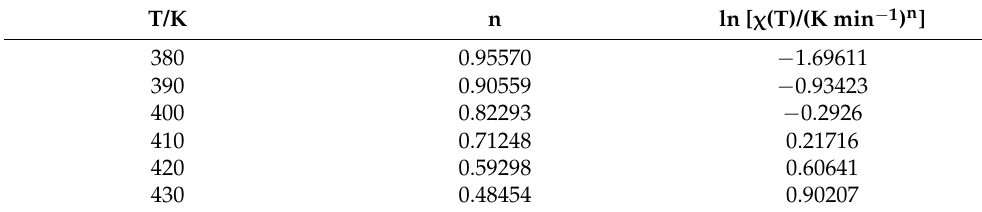
Figure 5. Ozawa plots for the F2 process. Numbers by the symbols are temperatures in K. Dash lines are least square fits to the respective points. Table 2. The Ozawa–Avrami model parameters for the simulated F2 data.